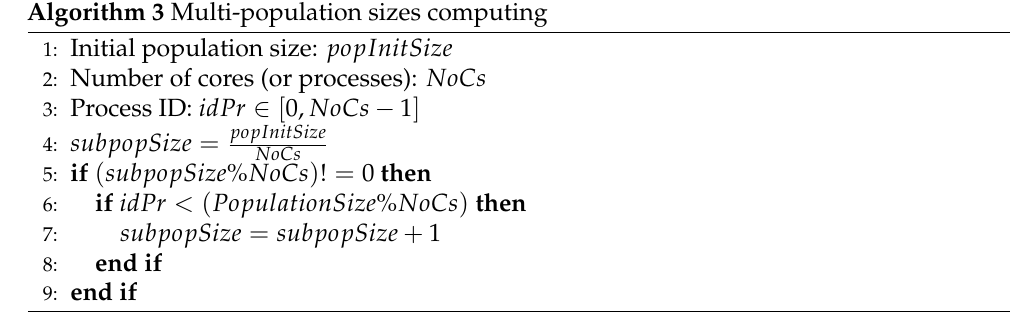
Algorithm 3 Multi-population sizes